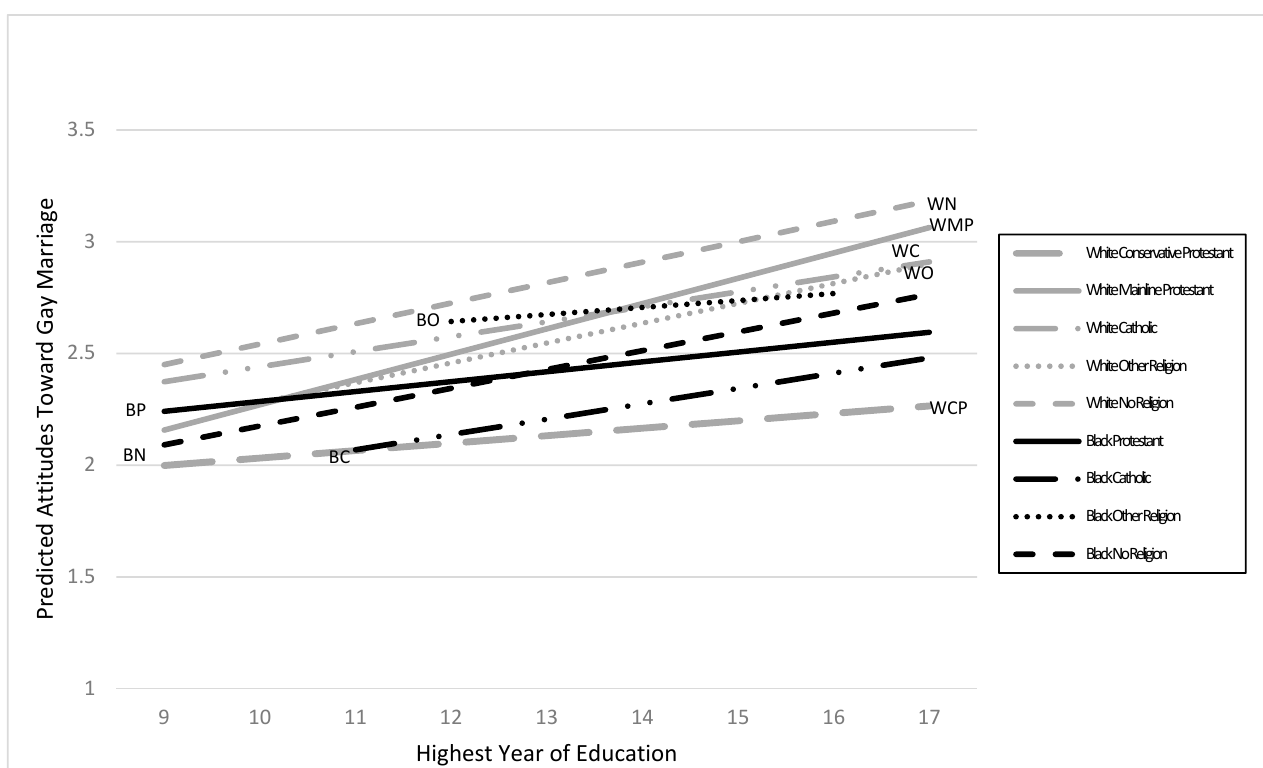
Figure A2. Views on gay marriage by race, religion, and education, Pew 2014 Religious Landscape Survey.